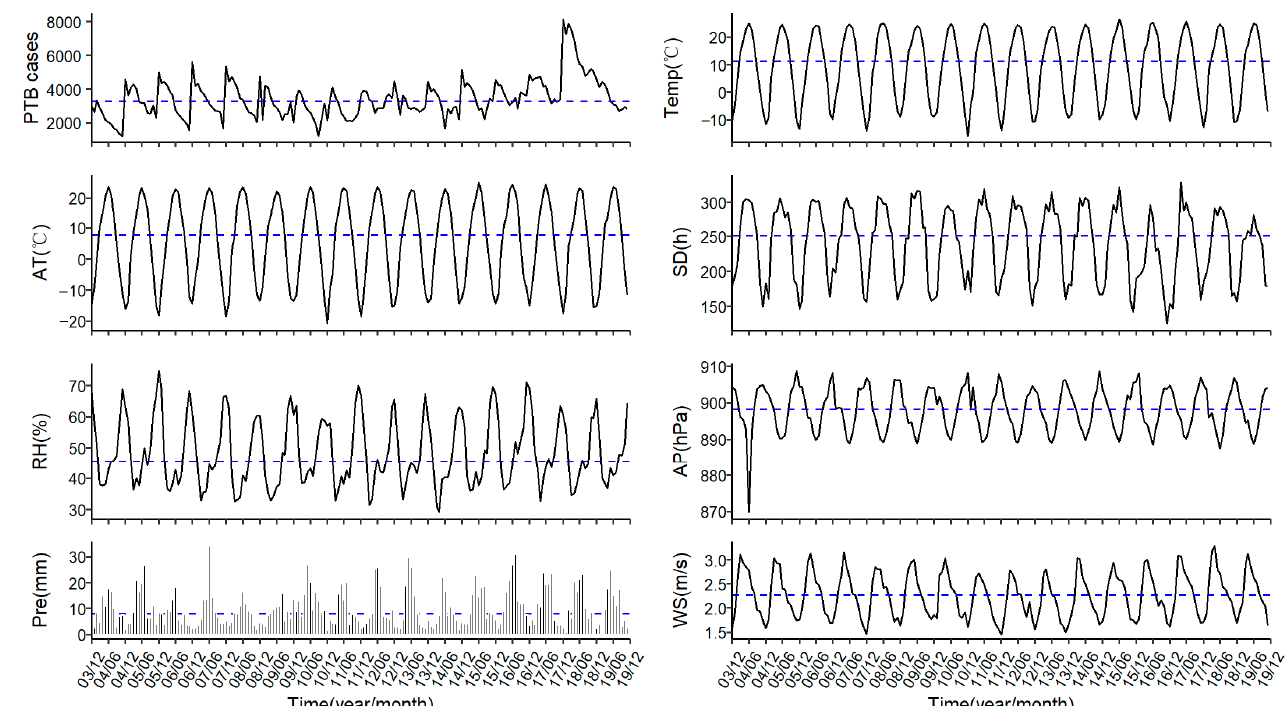
Figure 1. Time series of monthly PTB cases and meteorological factors in Xinjiang from 2004 to 2019. Abbreviations: Temp, air temperature (°C); AT, apparent temperature (°C); SD, sunshine duration (h); RH, relative humidity (%); AP, air pressure (hPa); Pre, precipitation (mm); WS, wind speed (m/s). Note: The blue dotted line represents the median.